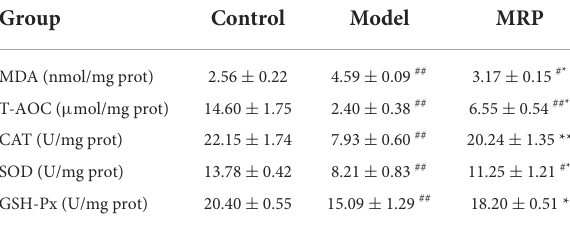
TABLE 1 Effect of MRP on the oxidative stress indices of the spleen.